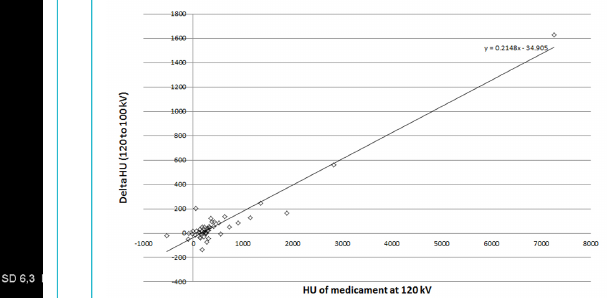
Figure 3: Co-Amoxicillin Sandoz 1 g at 100 kV with a density 6.6 Hounsfield Units.